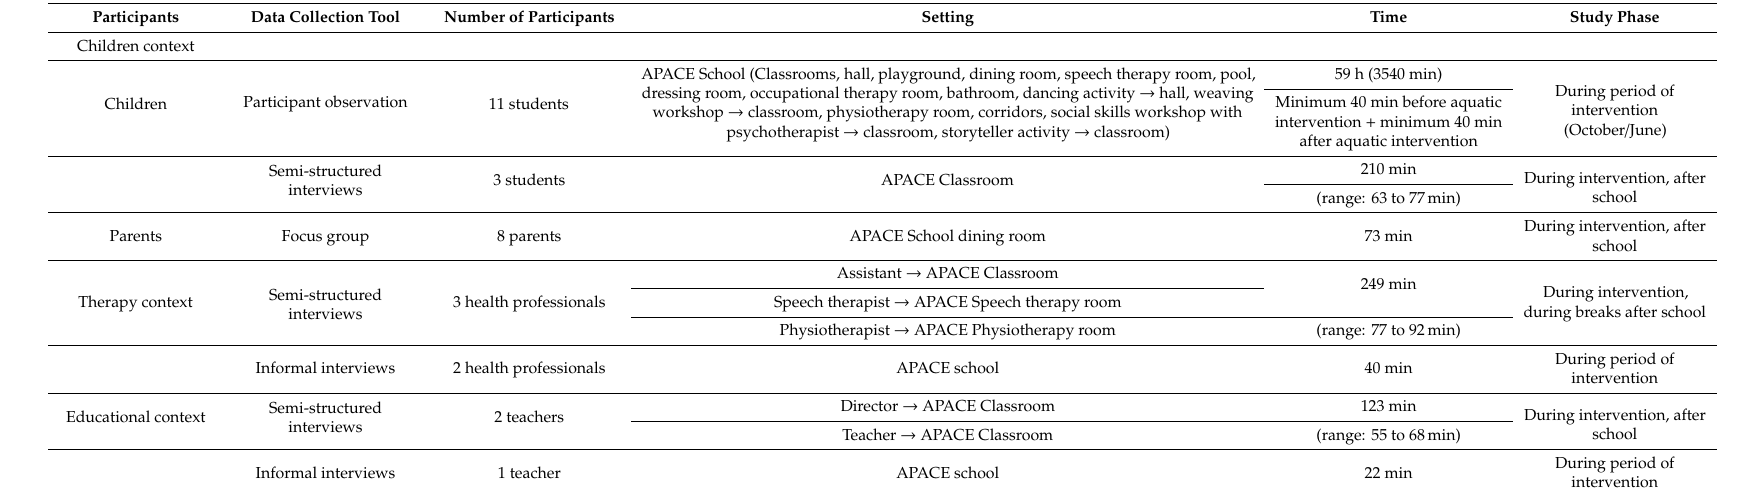
Table 2. Data collection